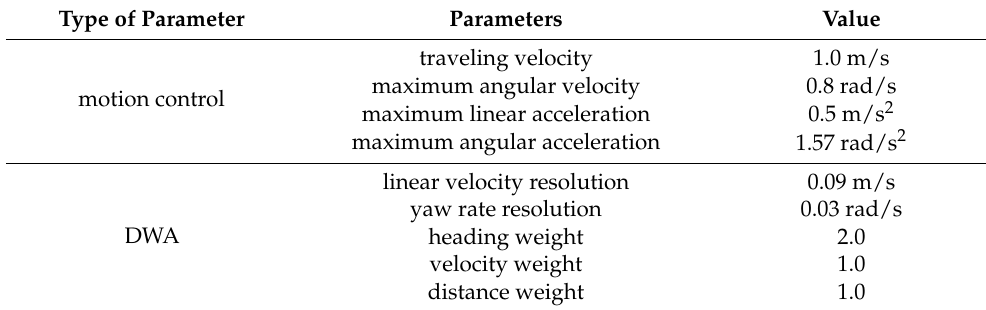
Table 1. Parameters of the navigation system and the robot platform during the experiment.